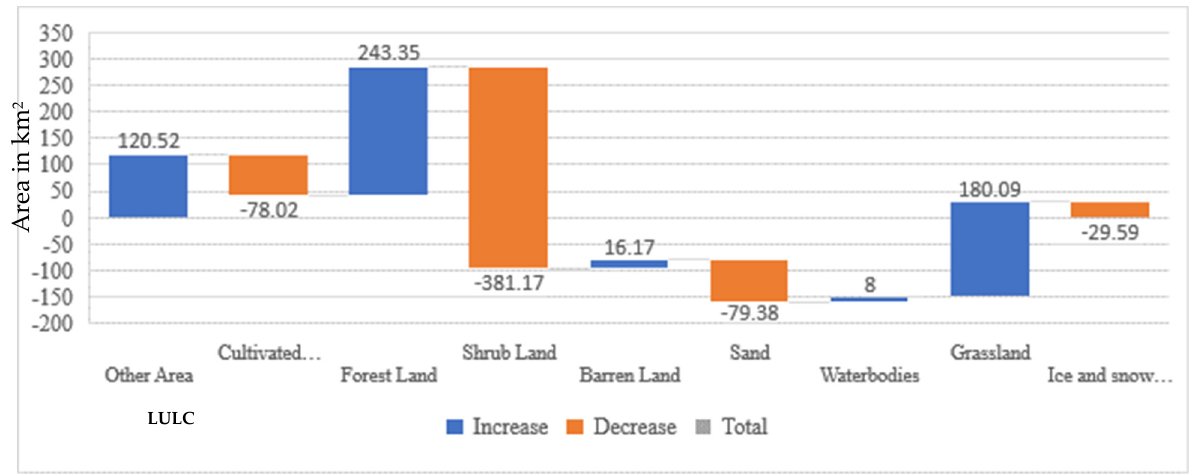
Figure 5. Gains and losses of LC classes between 2006 and 2016 (area in km 2 ) based on the total LC values.